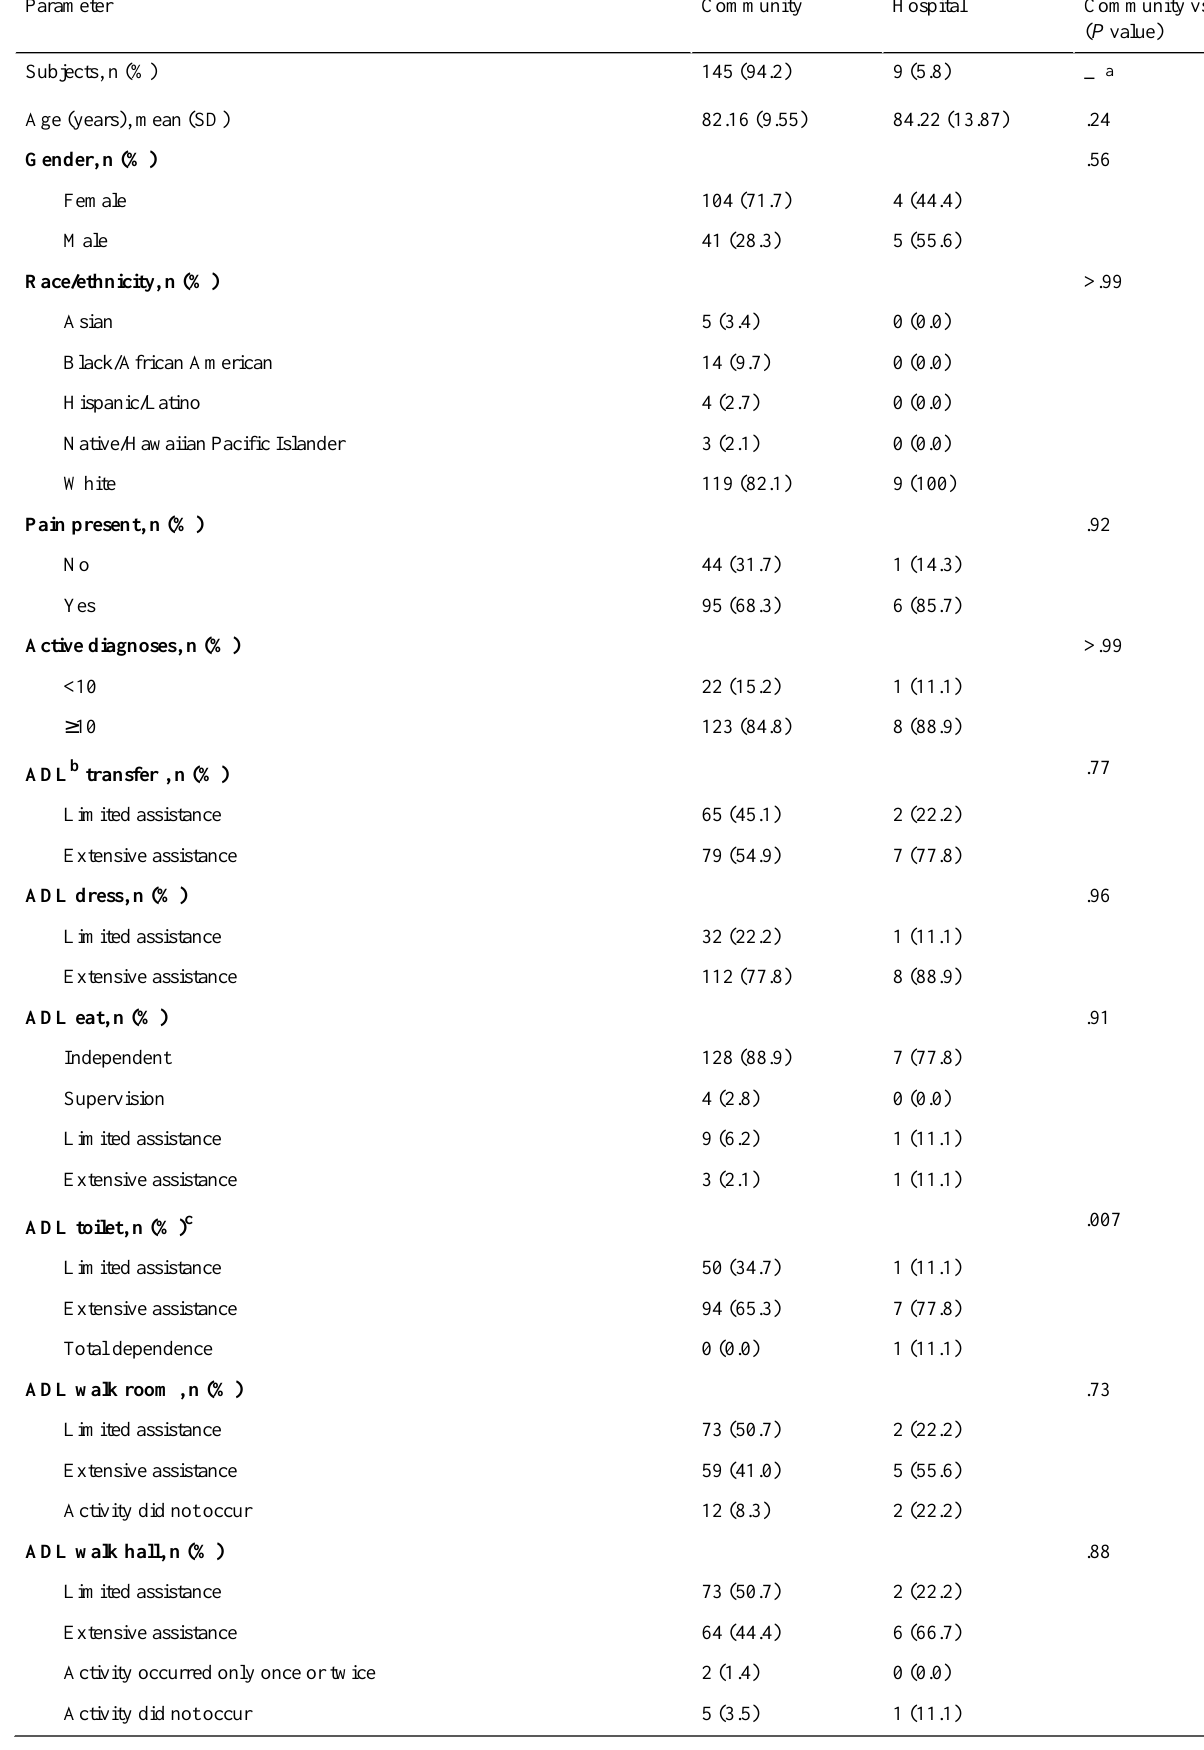
Table 4. Sociodemographic and clinical characteristics of the cohort of 154